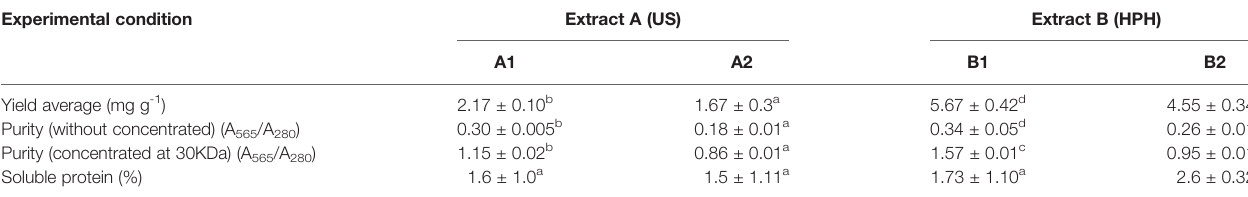
The average values ± standard deviations of 3 replicates per treatment are shown. Different letters in a row indicate signi fi cant differences (p<0.05) (ANOVA, Student Newman Keuls, p<0.05). A1, Ultrasound (60%amplitud; 10 min; water); A2, Ultrasound (60% amplitud; 20 min; Buffer phosphate); B1, High pressure (300 MPa; 2 passes; water); B2, High pressure (300 MPa;2 passes; buffer phosphate).